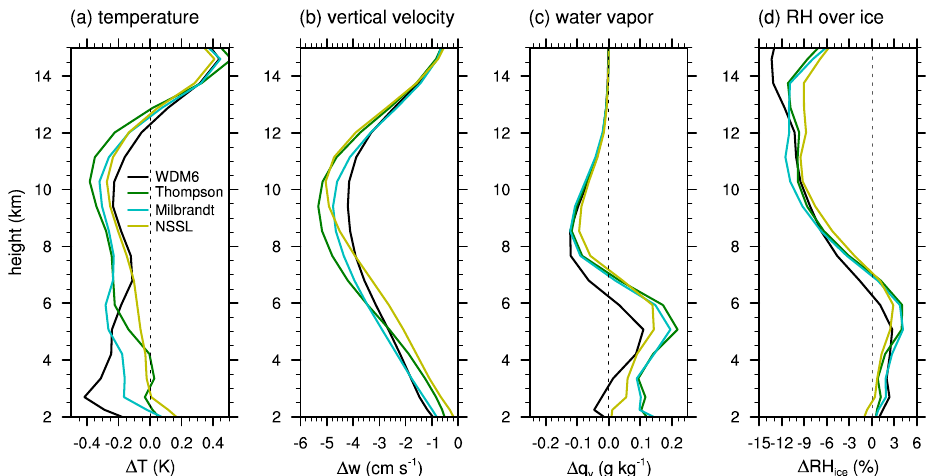
Figure 7. Vertical profiles of deviations in horizontally averaged ( a ) temperature, ( b ) vertical velocity, ( c ) water vapor mixing ratio, and ( d ) relative humidity with respect to ice obtained using the bulk microphysics schemes from those obtained using the bin microphysics scheme.